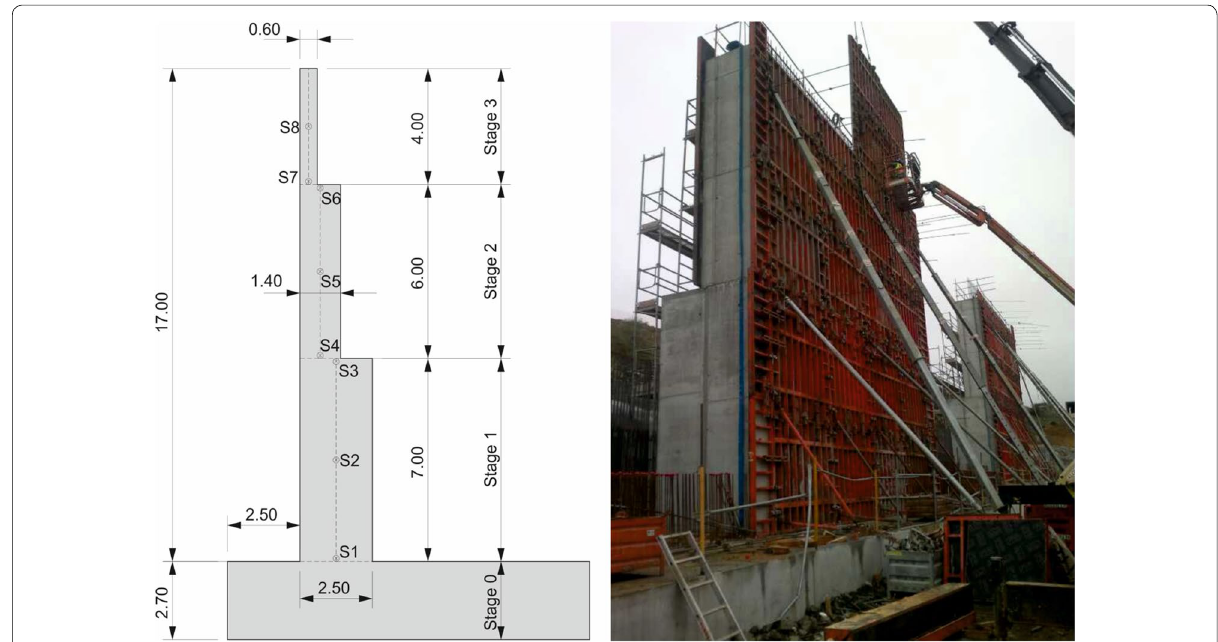
Fig. 15 Retaining wall construction in Loja (Granada, Spain): a main dimensions of the wall in meters, location of the temperature sensors S1 to S8 and indication of the construction stages and, b in situ construction of the wall.